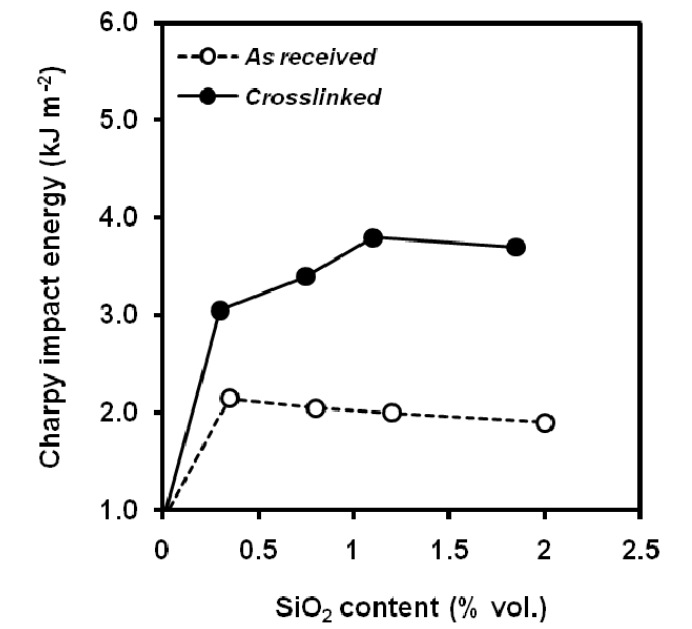
Figure 39. Effect of SiO crosslinking on notched aluminium oxide nanoparticles on 2 quasi-static and dynamic fracture parameters(adapted from